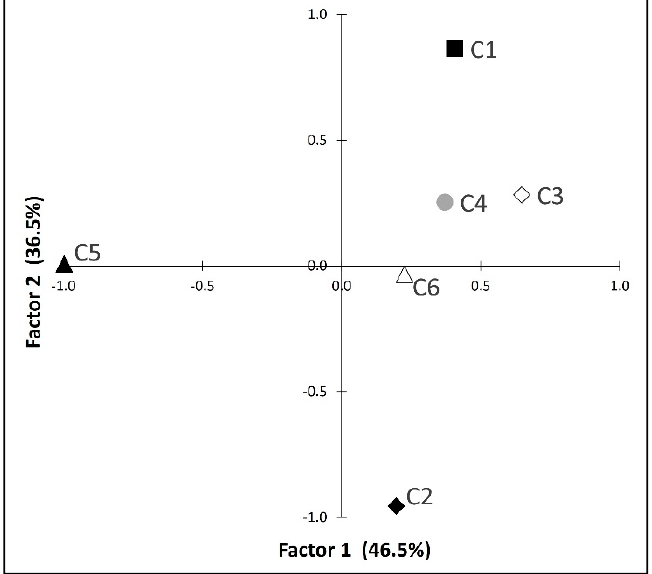
Figure 4. Factor loading for the variable components C1 to C6 from the PCA performed for all effluent and trench samples.